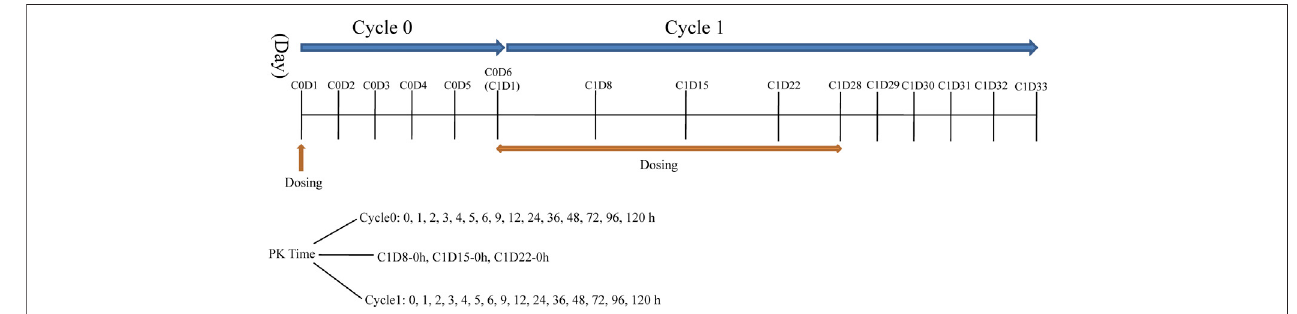
FIGURE 2 | The dosing schedule and sampling time-points in Cycle 0 and